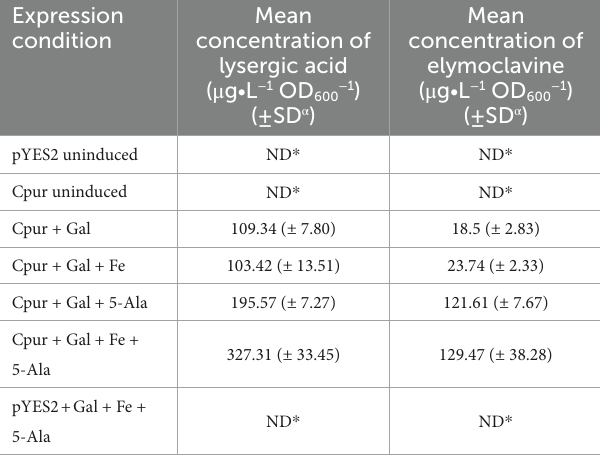
TABLE 1 Summary of the effects of supplementation on the activity of Cpur cloA in the presence of agroclavine. Expression